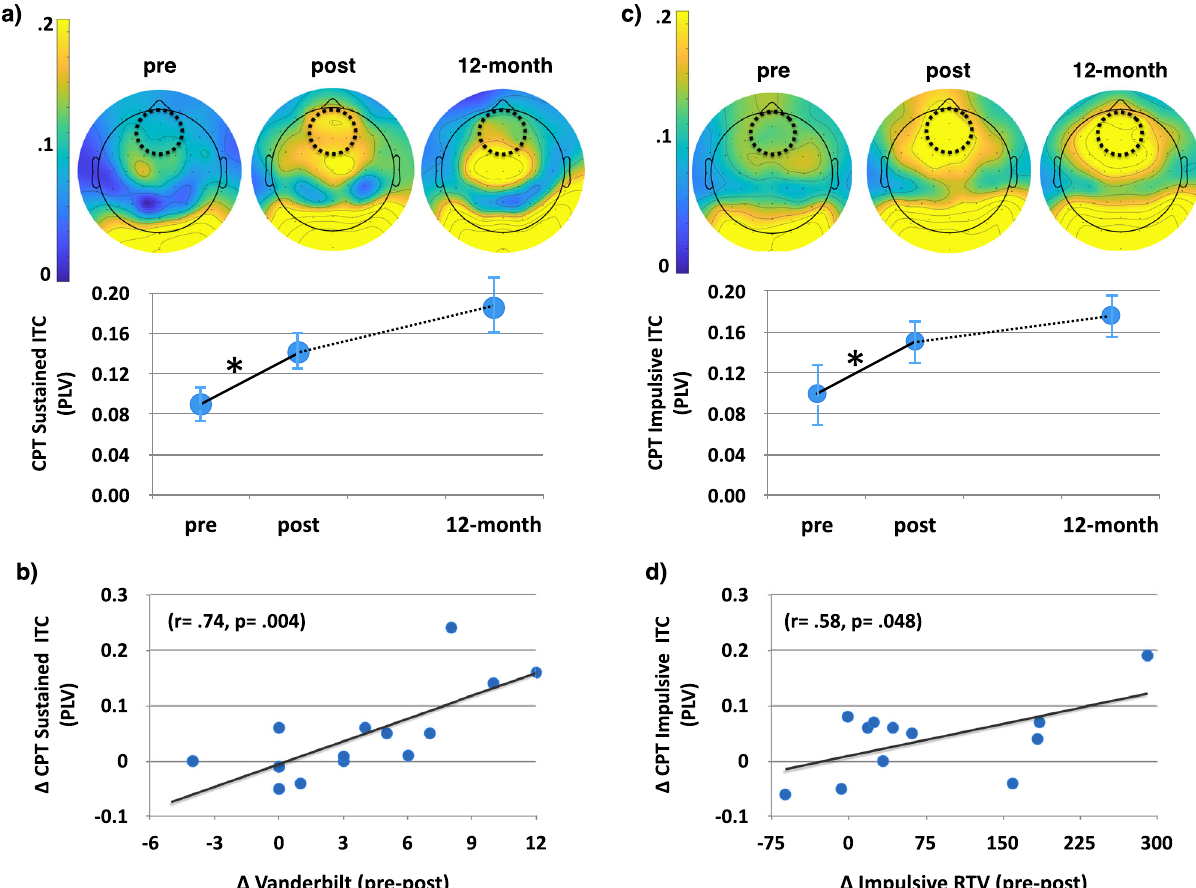
Fig. 4 Neural correlates of each CPT task over time. a Midline frontal theta inter-trial coherence (ITC) for the sustained condition of the CPT over time. b Correlation between the change in sustained ITC and the change in Vanderbilt inattention measure. c Midline frontal ITC for the impulsive condition of the CPT over time. d Correlation between the change in impulsive ITC and the change in impulsive RTV. The dashed circle on the topographic plot illustrates the electrodes where statistical analyses took place. * p < 0.05. Error bars represent